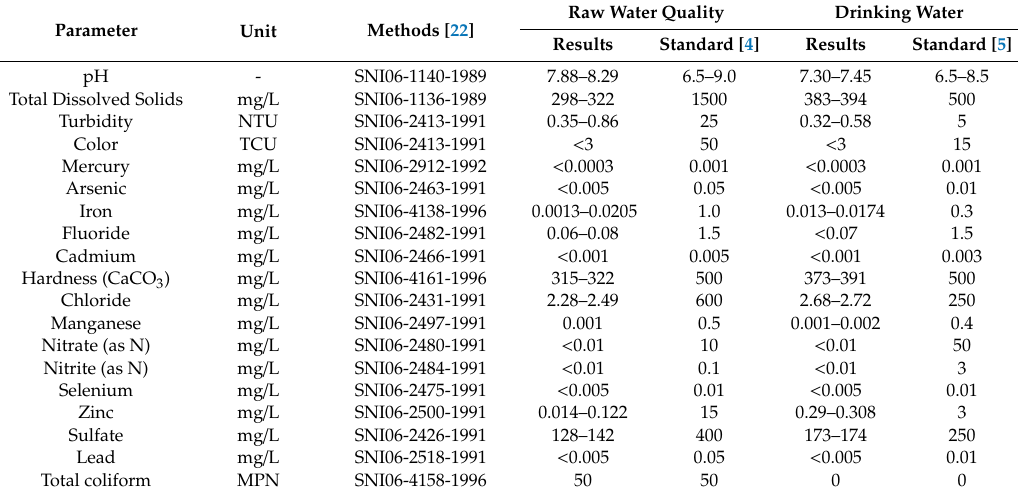
Table 4. Laboratory tests of raw water source